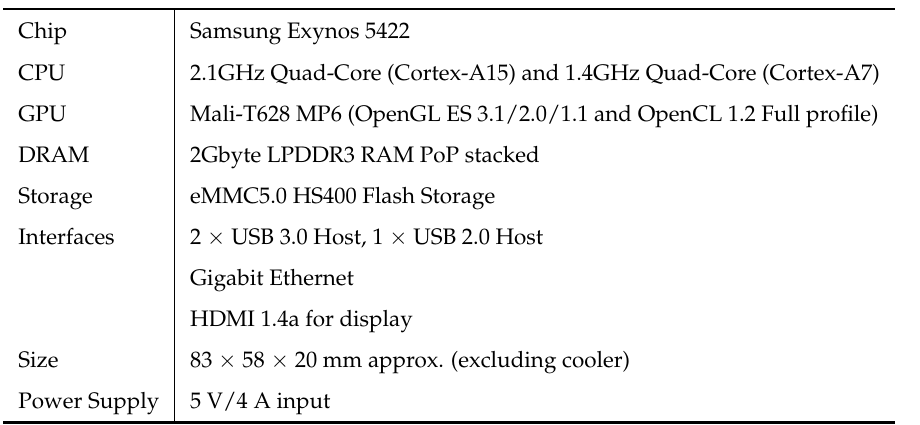
Table 2. Odroid XU4 sigle board computer specifications.